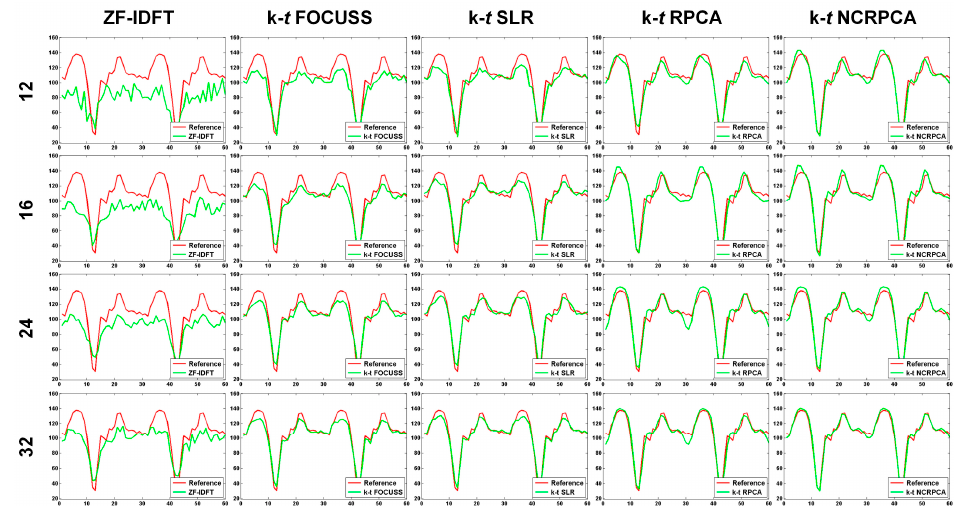
Figure 5. 1D profiles respectively generated by ZF-IDFT, k - t FOCUSS, k - t SLR, k - t RPCA and k - t NCRPCA for different number of radial projections (i.e., 12, 16, 24 and 32). (The images are best viewed in full-screen mode.)